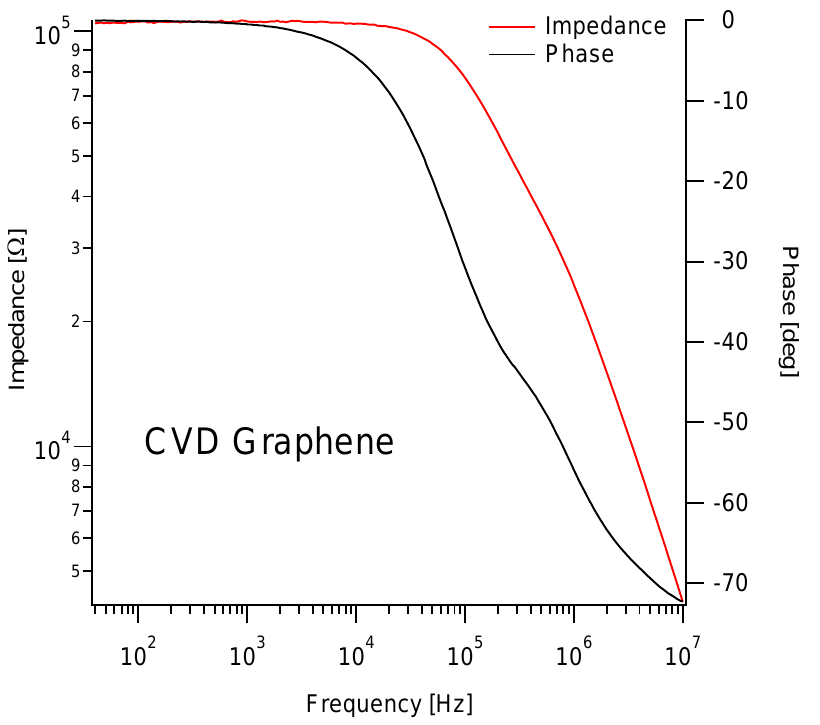
Figure 3. Impedance and phase of CVD-grown monolayer graphene on SiO 2 /Si